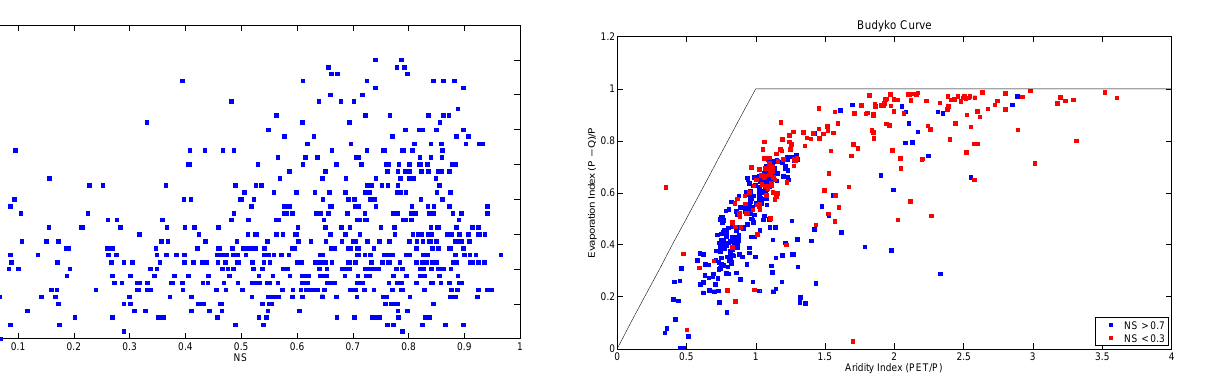
Fig. 6. Budyko diagram showing the high predictability (NS > 0.7) and low predictability (NS < 0.3)